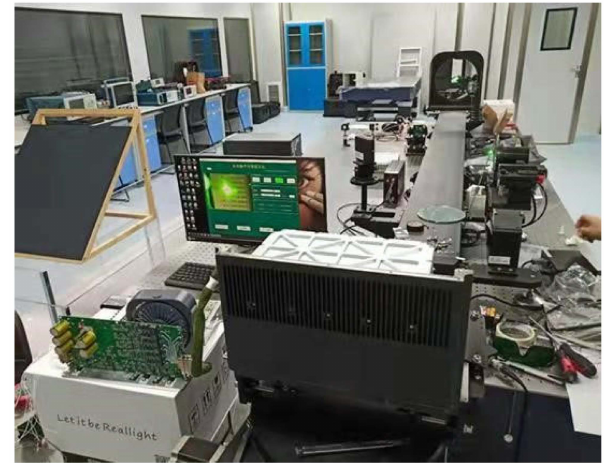
Figure 15. LiDAR system